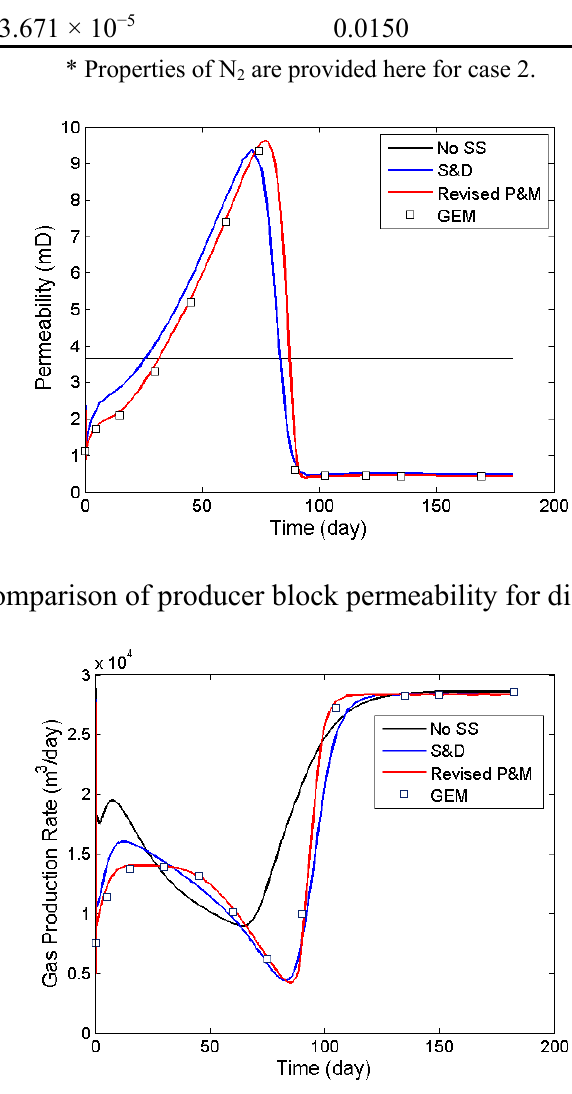
Figure 8. Comparison of gas production rates for different